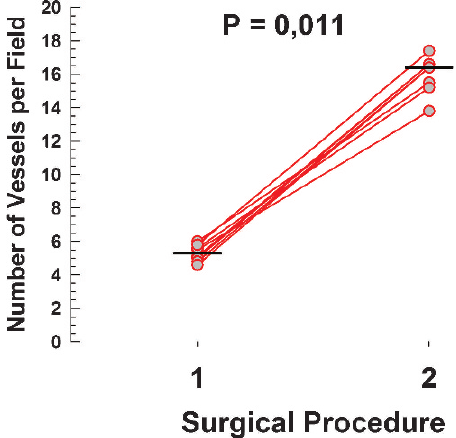
Figure 3 - Scoter plot with lines showing the variation of the adipocyte diameter between surgical procedure 1 and 2. Short thick lines represent the series median values.